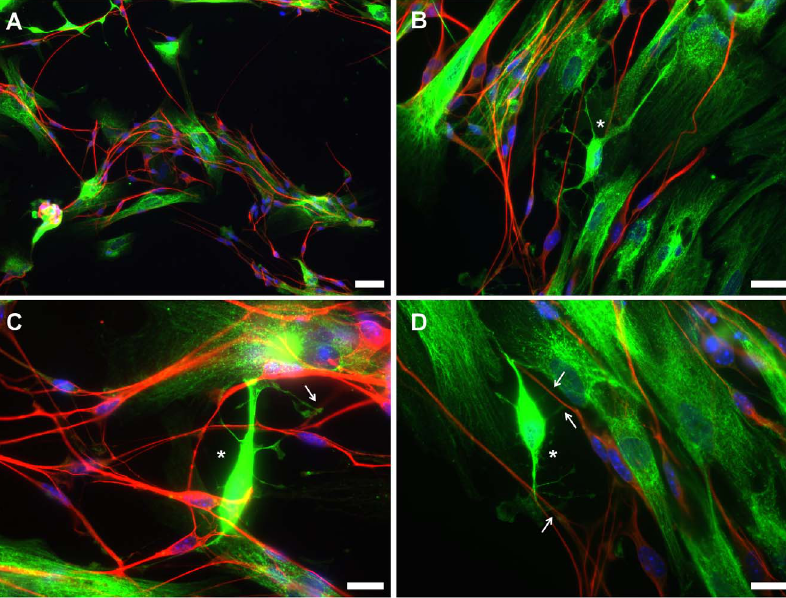
Figure 9. Immunofluorescence microscopy images of OL-like cells derived from hUCM-MSCs in co-culture with mouse dorsal root ganglion (DRG) neurons. The co-cultures were stained using an anti-human Golgi antibody (green) to specifically identify the human cells (OL-like cells derived form MSCs) and an anti-beta-III-tubulin antibody (red) to label the mouse DRG neurons. The images acquired in the green channel (anti- human Golgi antibody) were deliberately slightly overexposed to allow for a better understanding of the cellular morphology, which did not affect the identification of human versus mouse cells, as evidenced by the lack of green signal in the mouse DRG neurons (in red). Counterstaining of the nuclei was performed using DAPI (blue). It was apparent that the OL-like cells and DRG neurons tend to cluster together, as illustrated in a lower magnification image ( A ). Higher magnification images ( B-D ) suggest the existence of contact points (arrows) between branches of OL-like cells displaying an immature oligodendrocyte-like morphology (asterisks) and neurites. Scale bars correspond to 50 m m ( A ) or 20 m m ( B-D